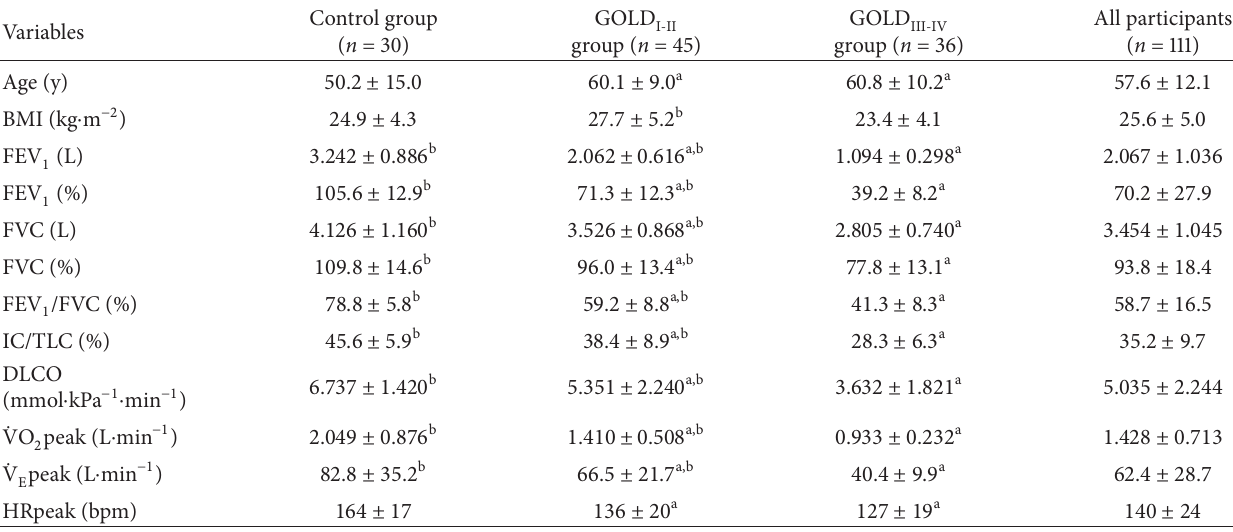
Table 1: Mean ± standard deviation of anthropometric and spirometric data and physiological data measured at voluntary exhaustion according to groups.